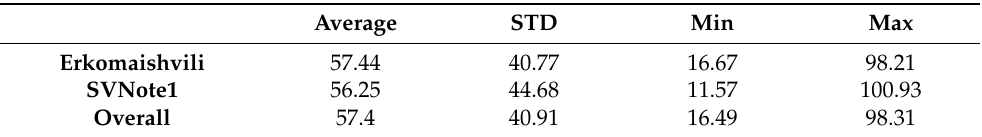
Table 3. The average, standard deviation, the minimum, and the maximum typical duration of transitions in both the datasets and